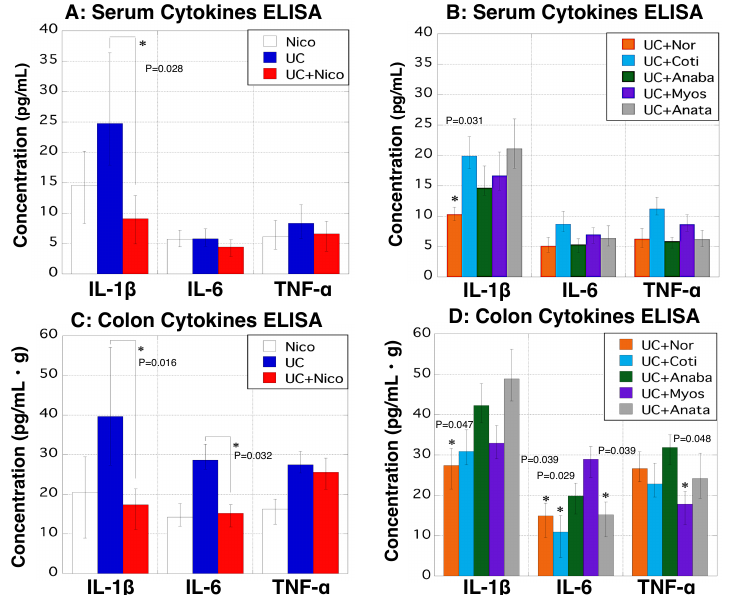
Figure 8. Changes in serum and colon levels of inflammatory cytokines in rats. ELISA was performed to measure cytokine levels in rat serum and colon tissues. ( A , B ) The y -axis indicates the concentrations of IL-1 β , IL-6, and TNF- α (pg/mL) in the sera of Nico (white), UC (blue), UC + Nico (red), UC + Nor (yellow), UC + Coti (light blue), UC + Anaba (green), UC + Myos (purple), and UC + Anata (gray) groups. ( C , D ) The y -axis shows the concentrations of IL-1 β , IL-6, and TNF- α (pg/mL) per gram of colon in Nico (white), UC (blue), UC + Nico (red), UC + Nor (yellow), UC + Coti (light blue), UC + Anaba (green), UC + Myos (purple), and UC + Anata (gray) groups. Data values are presented as the median ± max/min. * p < 0.05 (vs. the UC group). Anaba, anabasine; Anata, anatabine; Coti, cotinine; ELISA, enzyme-linked immunosorbent assay; IL-1 β , interleukin-1 β ; IL-6, interleukin-6; Myos, myosmine; Nico, nicotine; Nor, nornicotine; TNF- α , tumor necrosis factor- α ; and UC, ulcerative colitis.